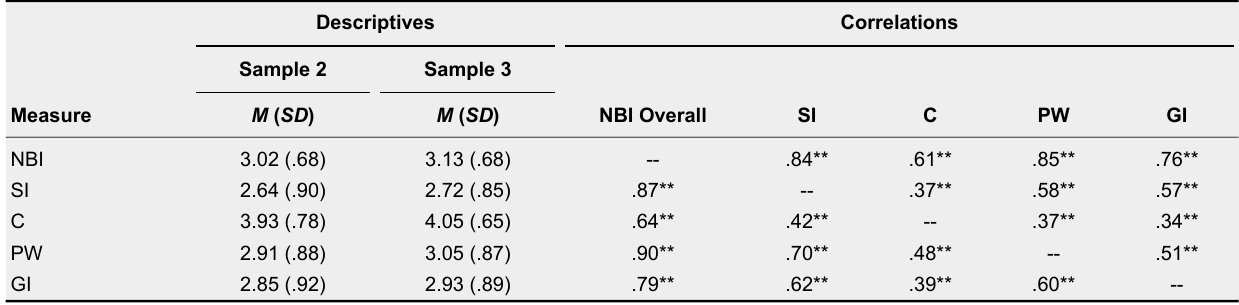
NBI and Subscales’ Descriptive Statistics and